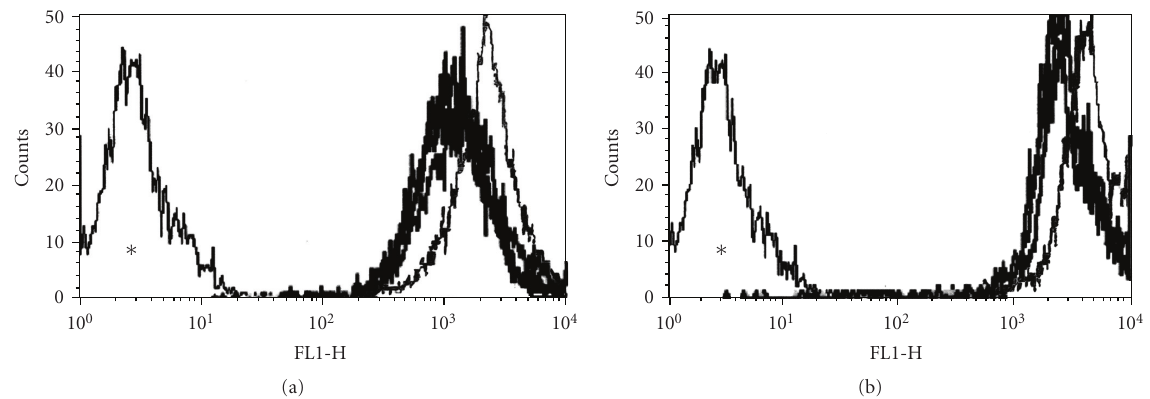
Figure 1: Analysis by flow cytometry of (a) Bryothamnion seaforthii lectin, BSL, and (b) Bryothamnion triquetrum lectin, BTL PITC, labeled. In this assay lectins were used at 10 μ g/mL. ( ∗ ) negative control BSA PITC-labeled.